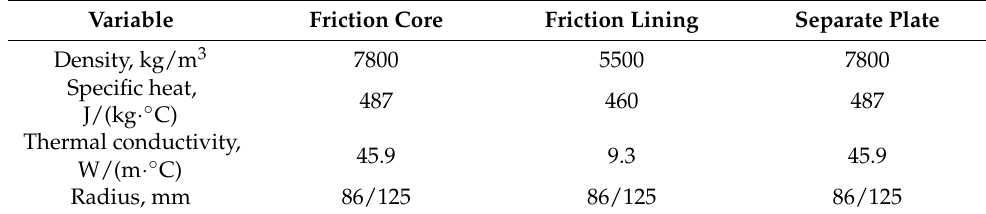
Table 2. Thermophysical parameters of the wet clutch.